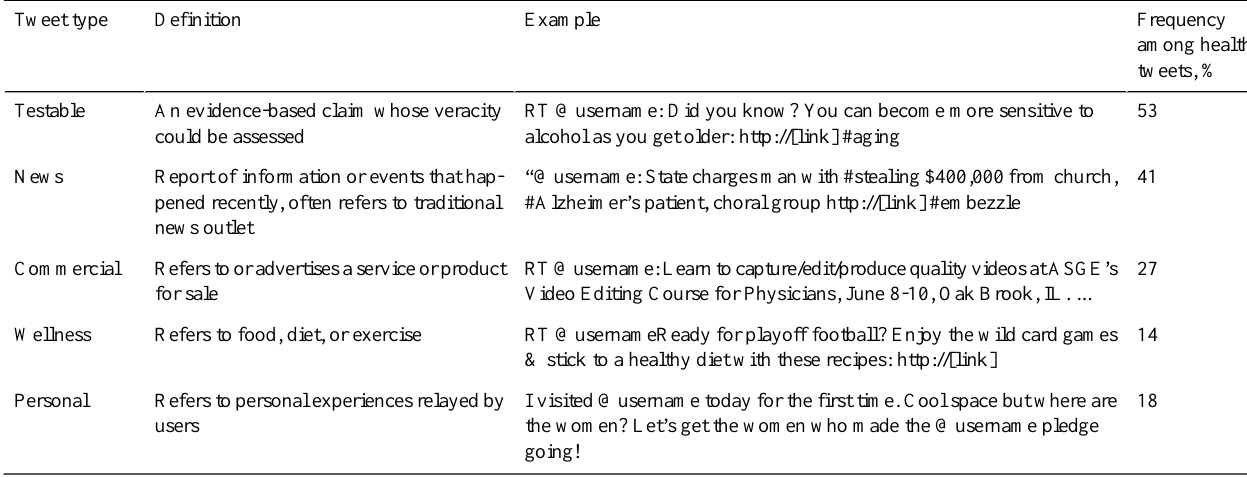
Table 1. Categories of health-related tweets identified via content analysis (n=346; content frequency may be greater than 100% because content areas were not mutually exclusive).